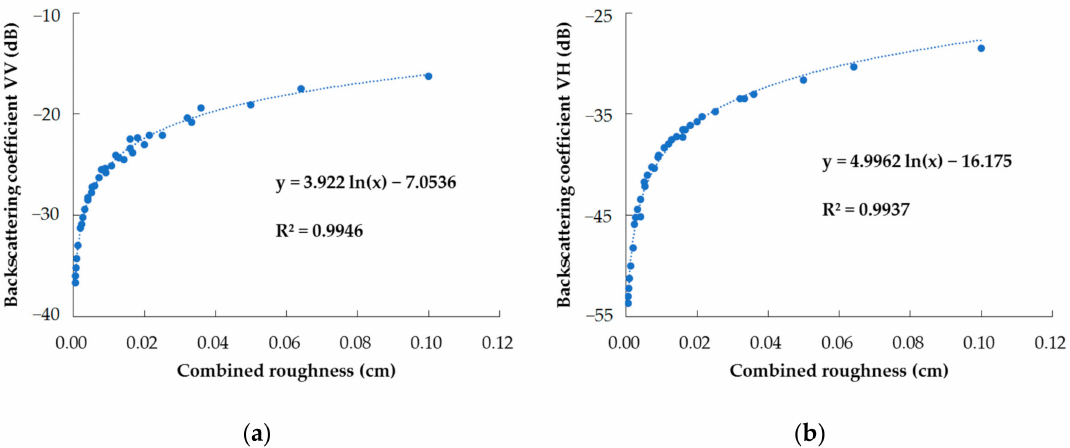
Figure 3. Responses of the backscattering coefficients and z s when the soil moisture is 20%: ( a ) VV polarization; ( b ) VH